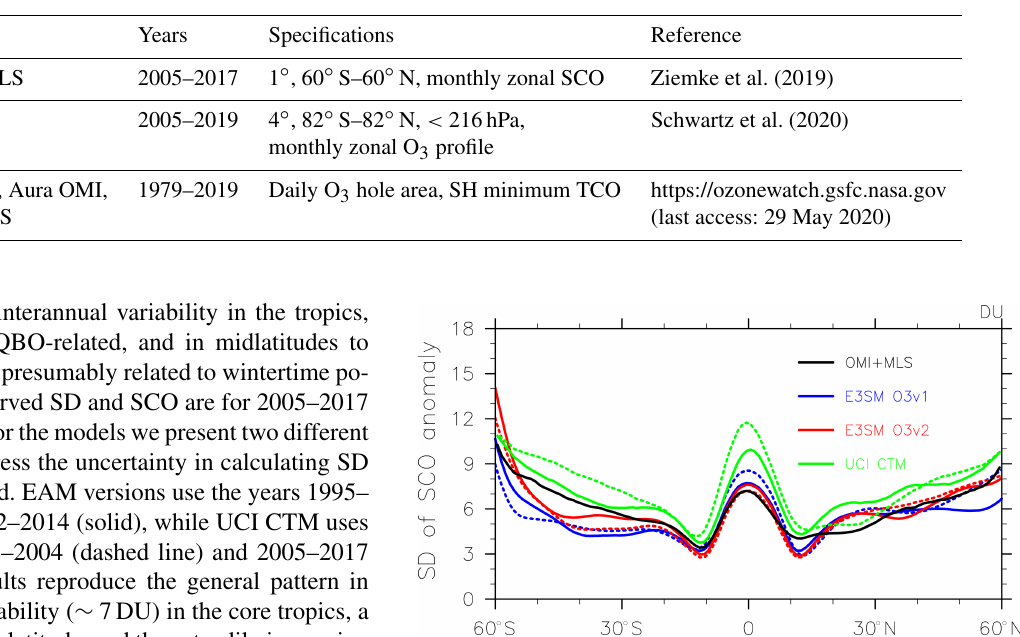
Table 2. List of evaluation data sets.